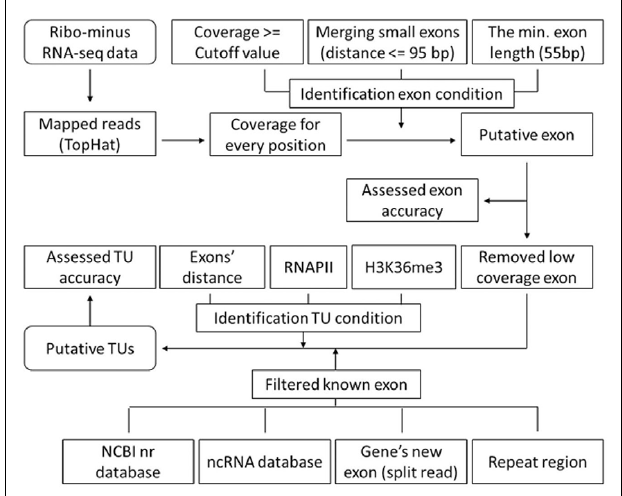
FIGUREA1 |A flowchart of gene identification process. We mapped the ribo-minus RNA-seq data usingTopHat and created the coverage file for genome and identified exons according to the coverage of each position ( > = cutoff value). Since 95% intron lengths are > or = 95bp, we merged small exons (distance < or = 95bp). Moreover, since 95% exon lengths are > or = 55, we only keep the exons whose length is equal or larger than 55bp to reduce false positives.We remove low coverage exons to reduce errors.We also filter known exons and build novelTUs on the basis of H3K36me3, RNAPII, and the different distance of adjacent exons between internal ofTUs and adjacentTUs.We evaluate the accuracy ofTU building by comparing ourTUs with Fantom3 RNAs of intergenic